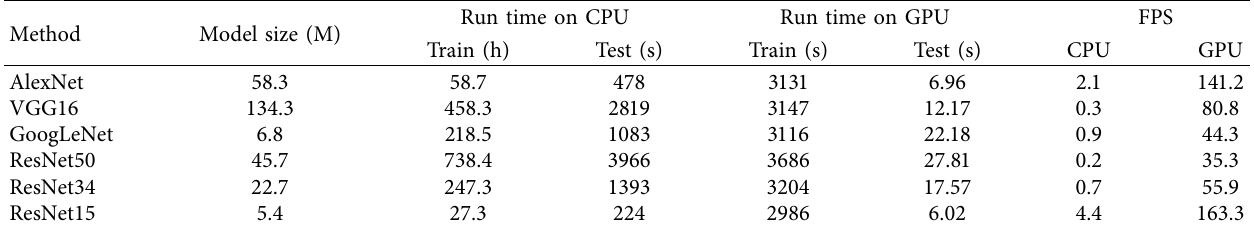
Figure 10: Histogram comparison of different methods. (a) Comparison of average recognition accuracy. (b) Comparison of FPS on the GPU. Table 5: Comparison of computational complexity of different